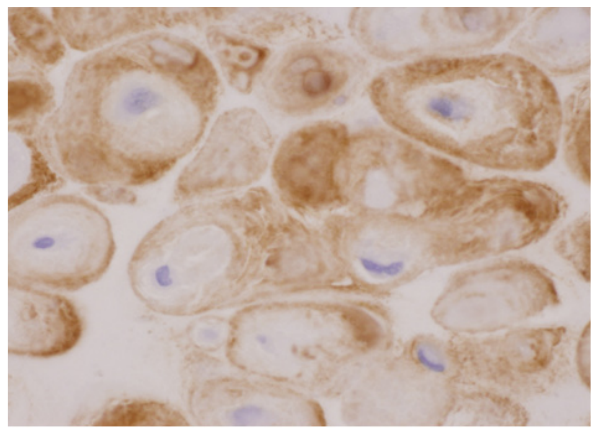
Fig. 10. Positivity of type VI collagen in pericellular rings of tumour chondrocytes, x200.